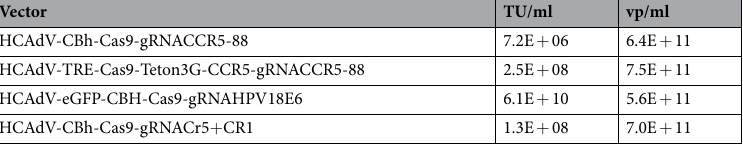
Table 1. Vector titers of CRISPR-HCAdV preparations. TU, transducing units; vp, viral